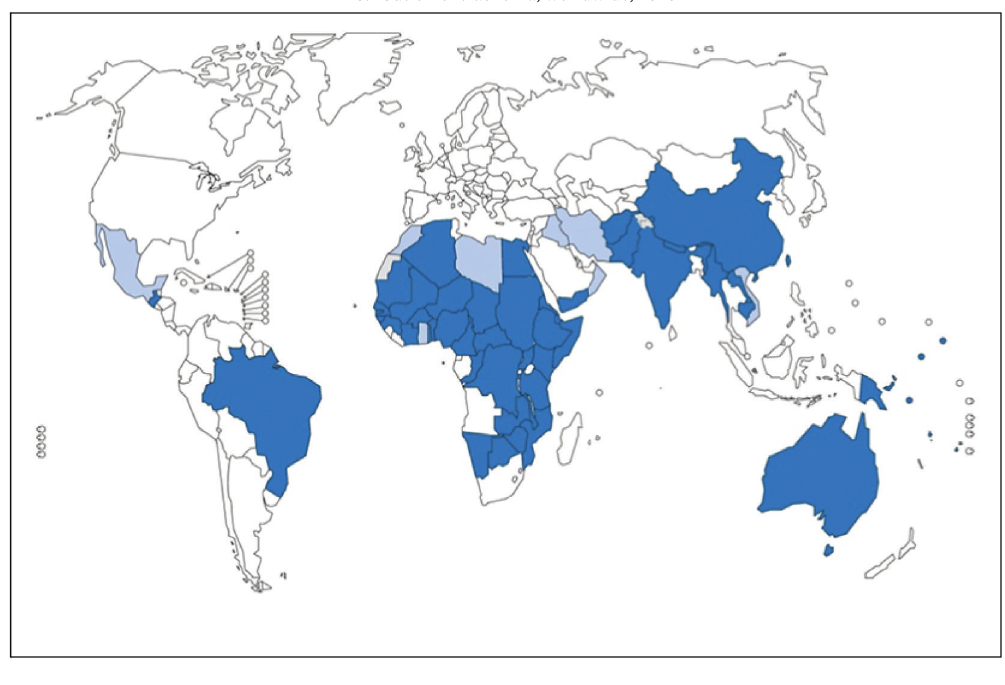
Figure 1: Global map of prevalence of trachoma. Figure courtesy of the World Health Organization [6].